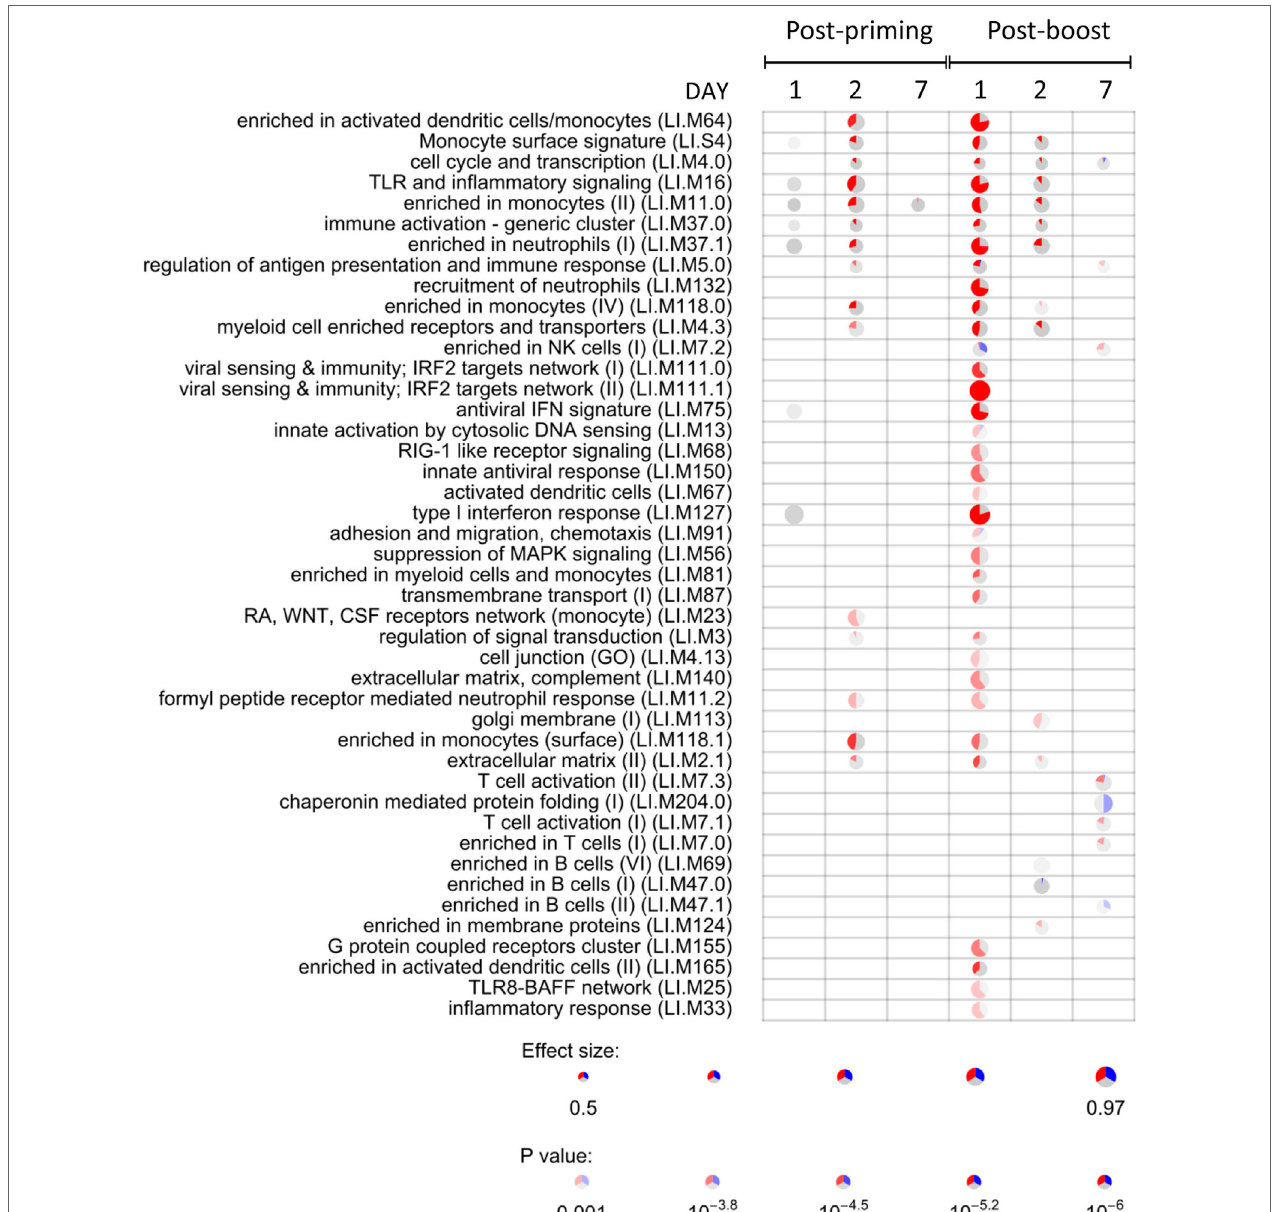
FigUre 4 | Activation of blood transcription modules (BTMs) by the CAF01 adjuvant. Each column represents a pairwise comparison between blood RNA samples from mice primed with H56 + CAF01 versus H56 alone. Both groups were boosted after 4 weeks with H56 alone. Blood samples were collected 1, 2, and 7 days after priming and after boosting. Activation of modules was tested using the FDR-ranked lists of genes generated by edgeR generalized linear model fitting and applying the CERNO test. Rows indicate different BTMs, which were significantly (FDR < 0.001) activated in at least one time point. Each module is represented by a pie in which the proportion of significantly upregulated and downregulated genes is shown in red and blue, respectively. The gray portion of the pie represents genes that are not significantly differentially regulated. The significance of module activation is proportional to the intensity of the pie, while the effect size (area under the curve) is proportional to its